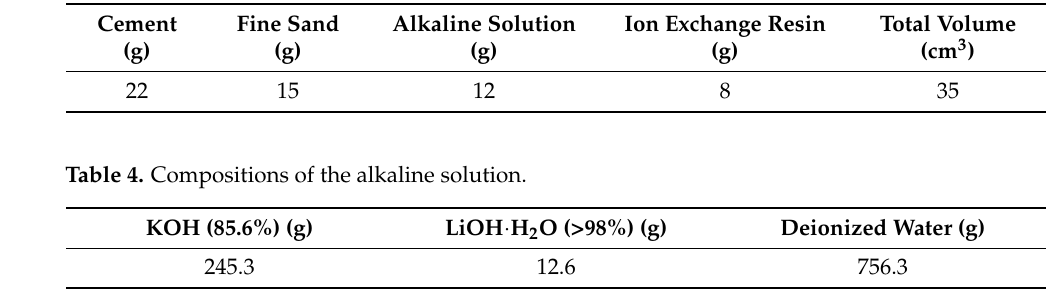
Table 3. Mix proportion of the cement-based electrolyte separator.